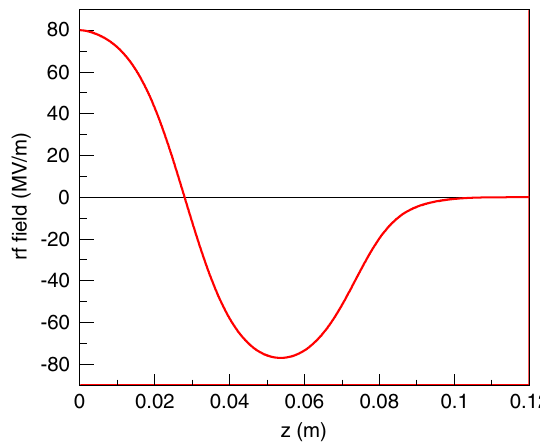
FIG. 2. The longitudinal component of the rf accelerating field on the beam axis at the gun. The field has two maxima: one at the cathode on the rear plane of the first cell and the other at the center of the second cell. When a beam passes from the first to the second cell, the field direction in the second cell is changed so that the beam can be accelerated by the field. The cathode is at z ¼ 0 .